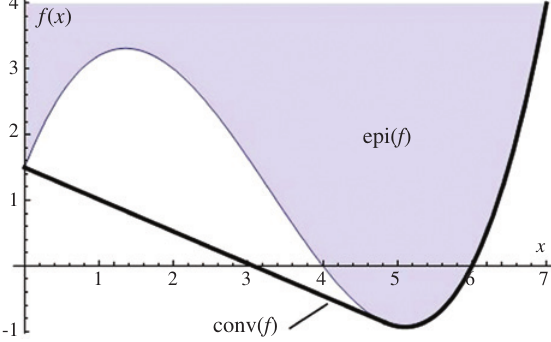
Figure 1: Convex envelope of a nonconvex polynomial over a closed convex interval in Example